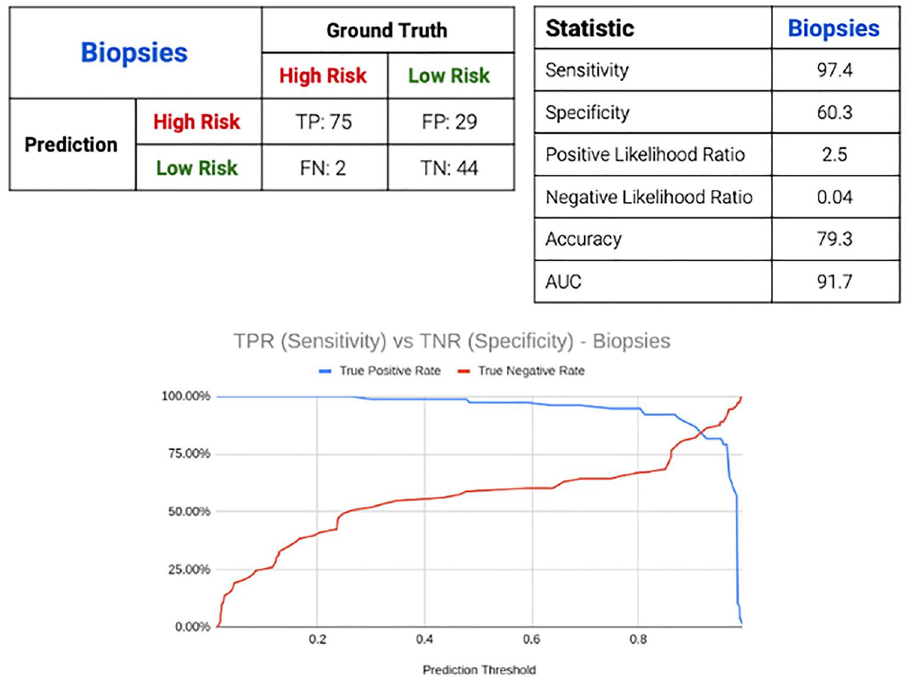
Figure 3. Performance data from applying the AI model on the validation set of 150 WSIs.